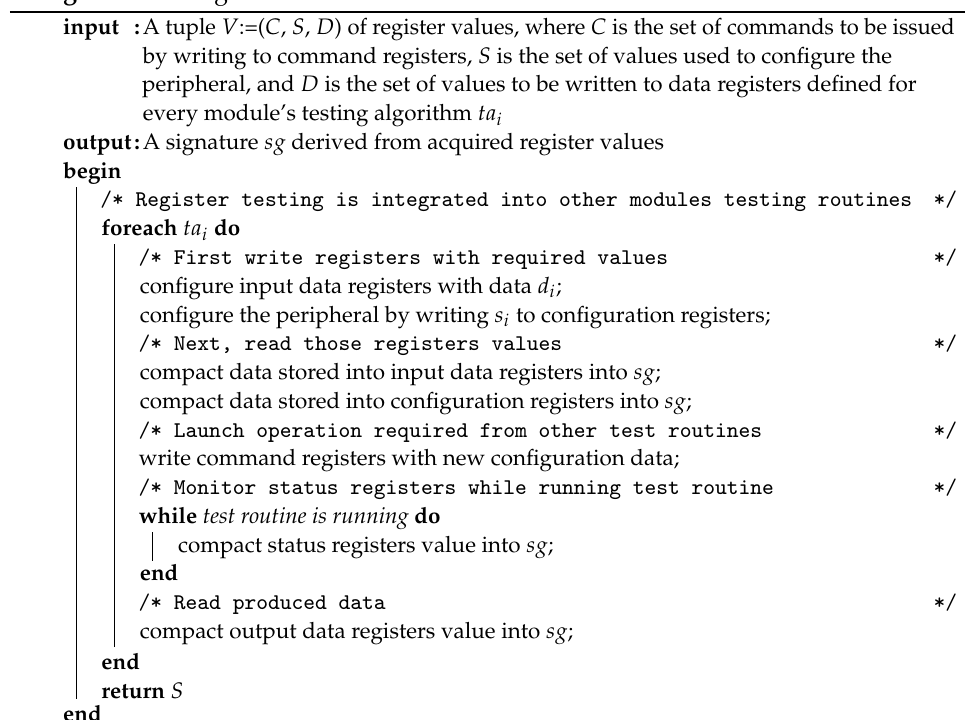
Algorithm 2: Register interface